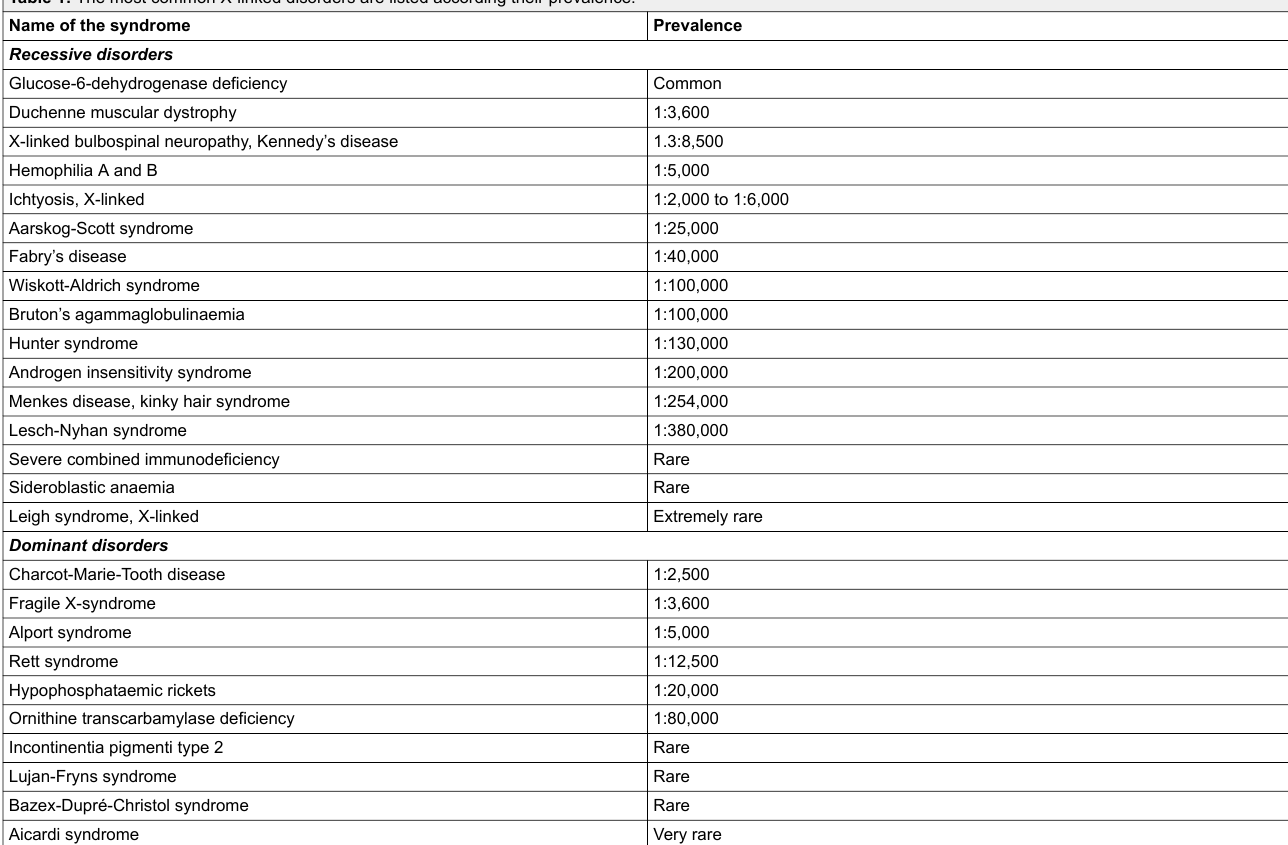
Table 1: The most common X-linked disorders are listed according their